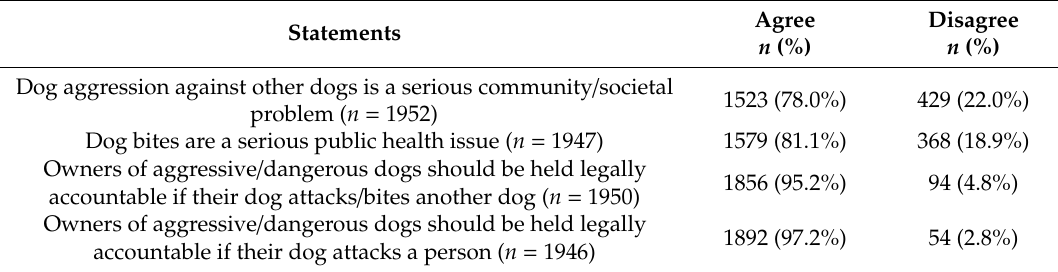
Table 1. Dog aggression